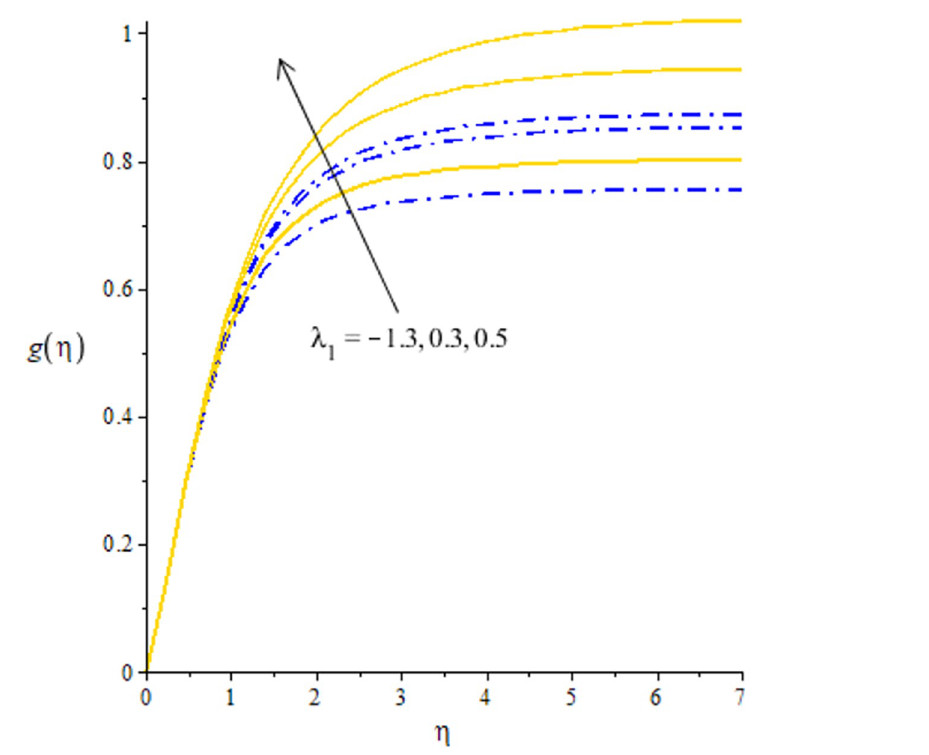
Fig 7. Distribution of velocity versus λ 1 .